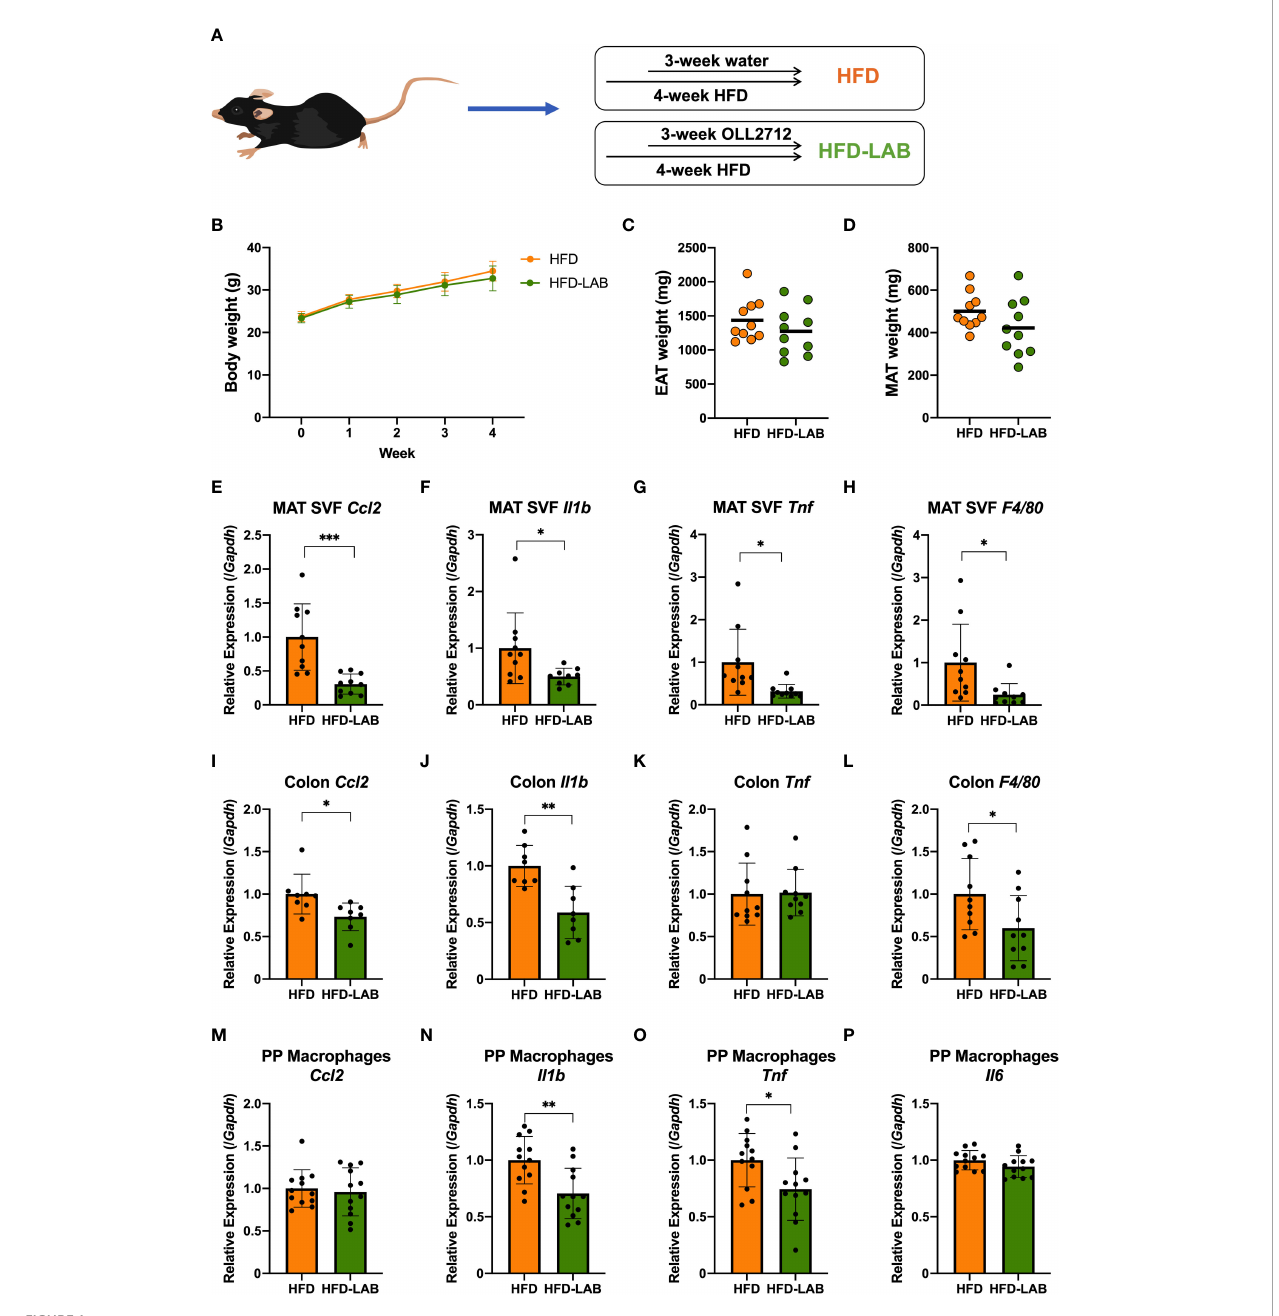
FIGURE 1 Oral administration of L. plantarum OLL2712 alleviated the in fl ammation of adipocytes, colon and PP macrophages in mice but changed neither the body weight nor the adipose tissue weight. C57BL/6N male mice were fed a HFD (60% kcal from fat) for 4 weeks from 8 weeks of age. (A) In the last 3 weeks, mice were administered OLL2712 daily (4 mg dissolved in 200 m L water per dose), and mice administered water simultaneously were used as a control group (HFD). (B) Mice were weighed once per week. The weights of the epididymal adipose tissue (EAT) (C) and mesenteric adipose tissue (MAT) (D) were measured after 3 weeks of treatment with OLL2712 and compared with the control group. The SVF cells were isolated from the MAT. The mRNA expression of CCL2 ( Ccl2 ) (E) , IL-1 b ( Il1b ) (F) , TNF ( Tnf ) (G) , and F4/80 ( F4/80 ) (H) was measured by qPCR. The mRNA expression of CCL2 ( Ccl2 ) (I) , IL-1 b ( Il1b ) (J) , TNF ( Tnf ) (K) , and F4/80 ( F4/80 ) (L) in colon tissue was measured by qPCR. Macrophages were isolated from PPs in the mice. The mRNA expression of CCL2 ( Ccl2 ) (M) , IL-1 b ( Il1b ) (N) , TNF ( Tnf ) (O) , and IL-6 ( Il6 ) (P) was measured by qPCR. The results are representative of two independent experiments and are shown as the mean ± standard deviation (n = 8 - 12). * p <0.05; ** p <0.01; *** p <0.001 (assessed using Student ’ s t -test). HFD, high-fat diet; LAB, lactic acid bacteria ( L. plantarum OLL2712); MAT, mesenteric adipose tissue; SVF, stromal vascular fraction; PP, Peyer ’ s